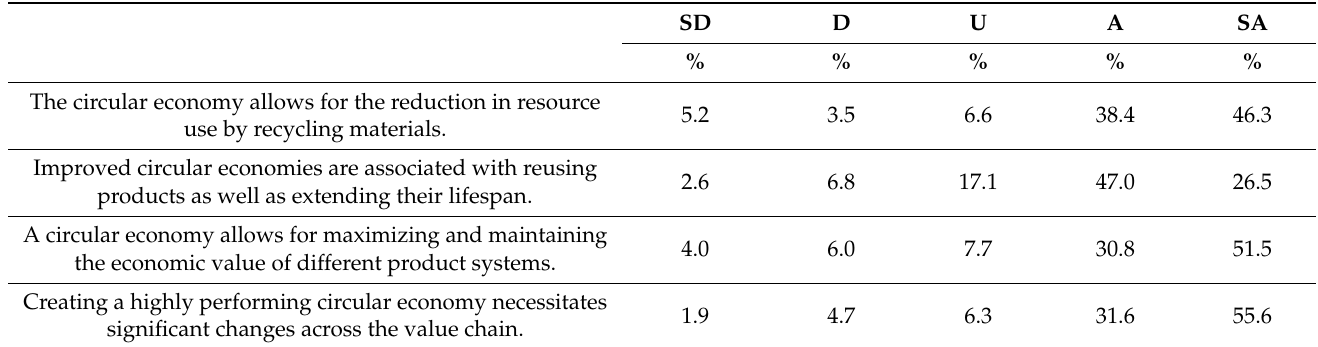
Table 5. Results on circular economy business models.